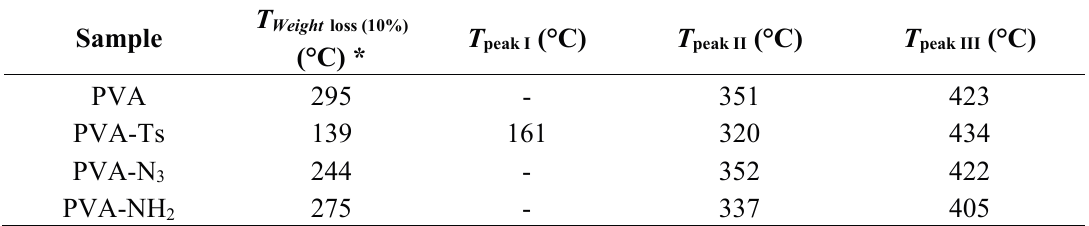
Table 2. The data obtained from TGA and DTG curves of unmodified PVA, PVA-Ts, PVA-N 3 and PVA-NH 2